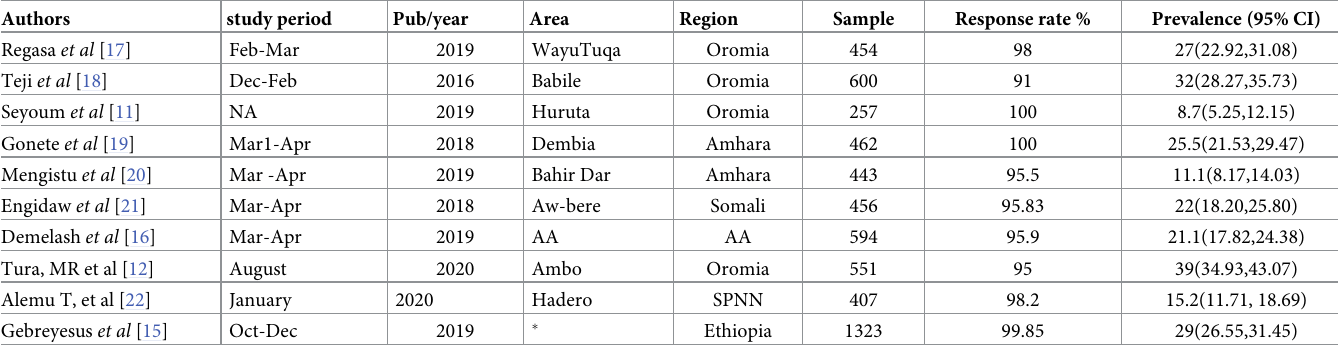
Table 1. Characteristics of 10 studies reporting the prevalence of anemia among adolescent girls in Ethiopia, 2021.